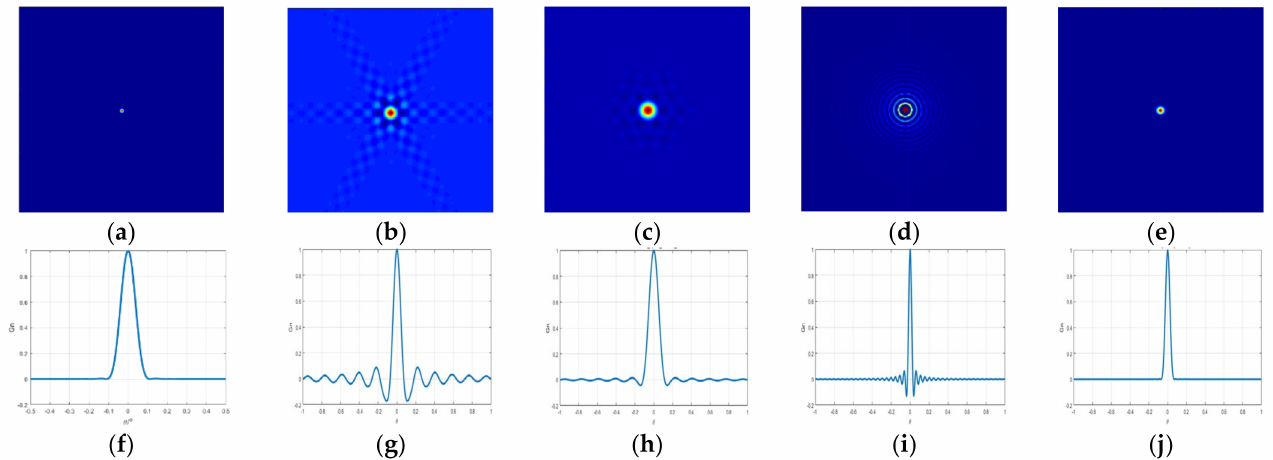
Figure 5. Simulated 2-D antenna pattern of RA and synthetic AF of SAIR at 50.3 GHz. ( a ) GMR, ( b ) GeoSTAR with a rectangular window, ( c ) GeoSTAR with a Blackman window, ( d ) GIMS with a rectangular window, and ( e ) GIMS with a Blackman window. The simulated 1-D antenna pattern and synthetic AF of SAIR. ( f ) GMR, ( g ) GeoSTAR with a rectangular window, ( h ) GeoSTAR with a Blackman window, ( i ) GIMS with a rectangular window, and ( j ) GIMS with a Blackman